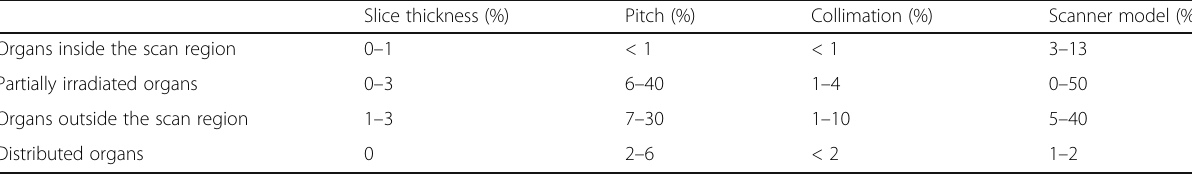
Table 4 First level of analysis using CT-Expo: organ dose variations found according to slice thickness, pitch, collimation and scanner model. For the slice thickness, we compared 1 and 3 mm, keeping the latter as reference. We set pitch at 0.8, 1.0, and 1.4 (with 1.4 as reference), collimation at 19.2 and 40.0 mm (with 19.2 mm as reference). For each organ, we calculated the discrepancies as difference of the values obtained. These discrepancies were then normalised to the organ dose at reference condition. We reported here only the minimum and the maximum values of discrepancy found for each class of organs subdivided according to the position relative to the scan region Slice thickness